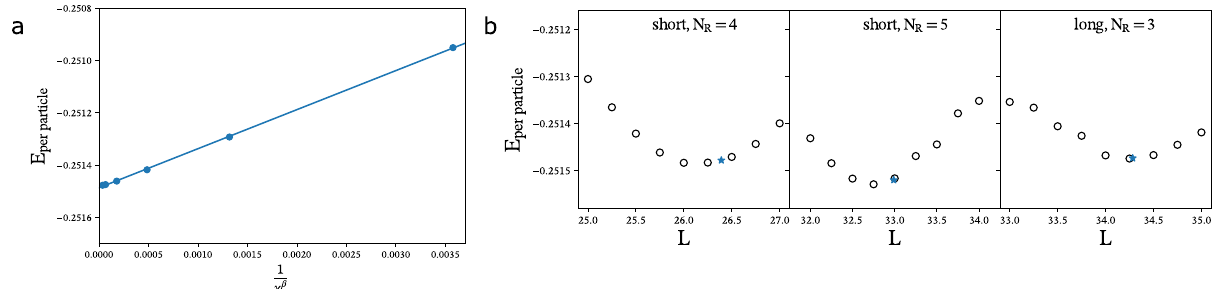
Fig. 5 Estimate energy density by DMRG and determine lattice shape from energy data. a Estimate energy by extrapolating DMRG data with different bond dimension χ . The unit of energy is e 2 / ϵ l . Our scheme is fi tting the ansatz E ( χ ) = E − b / χ β by fi tting E ( χ ) as a linear function of 1/ χ β ; − b is the fi tted slope and an estimation of E is obtained from the intercept. We adjust the other fi tting parameter β to do multiple linear fi ttings and determine β as that maximises the r value. The plot with β = 1.44, is an example of such fi t for the ground state at cylinder circumference L = 26, fold of ‘ rotational ’ symmetry N R = 4 and 1/6 fi lling. b Determining lattice shape and energy density by searching optimal L fi ned as the location of energy minimum for nearby L . The op de energies are extracted using the method illustrated in ( a ). We use the lattice shapes of systems with L op to estimate that of the in fi nite 2D system. The fold of ‘ rotational ’ symmetry N R is also the number of unit cells along the tangential direction. For a simple rhombus lattice, the length of one diagonal of the rhombus unit cell l R can be determined as N R l R = L op . The plot shows the calculation for systems at fi lling 1/6 and the isotropic limit. We calculate systems with three different N R . Two of them have the short rhombus axis along the tangential direction and one has the long rhombus axis along the tangential direction. In the thermodynamic limit, a triangular lattice Wigner crystal is expected. For exact triangular lattices, the optimal should be at where denoted by star symbols ( L * ). The data shows that L op s deviate from L * s by small values. Accordingly, the estimated l R deviates from ideal values l (cid:4) . The deviation is R around 1.5% for N R = 4, 0.7% for N R = 5 (short); around 0.02% for N R = 3 (long). Also, we see the estimated energy densities differ by ~10 − 5